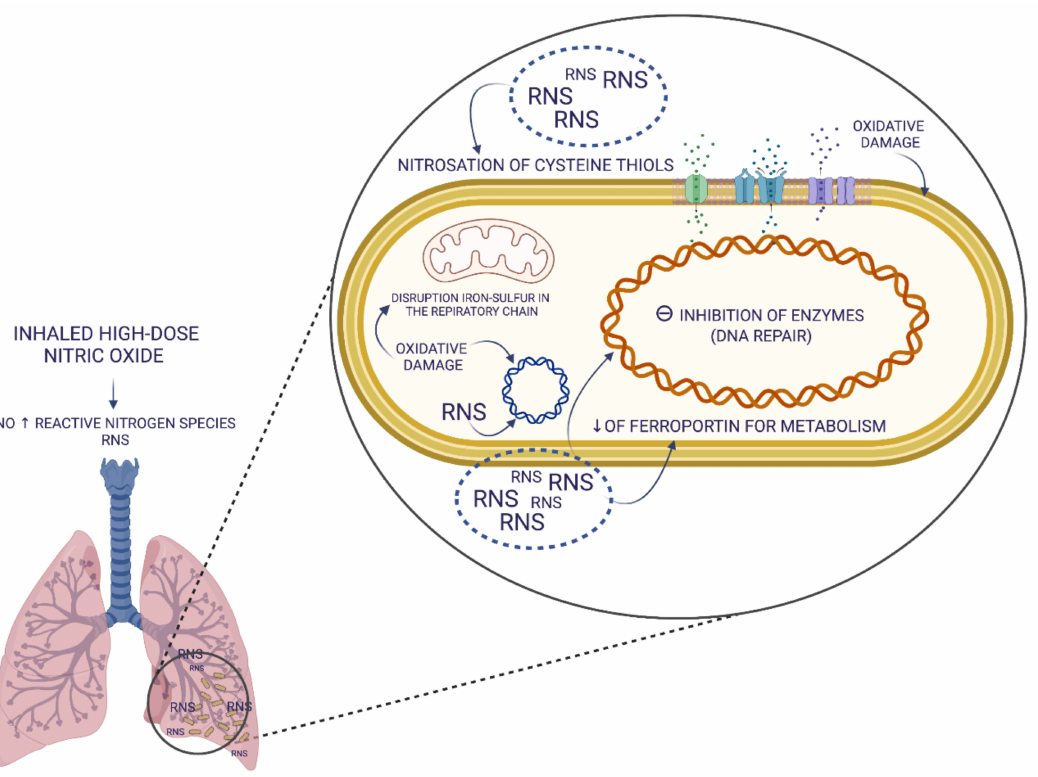
Figure 1. Schematic representation of multiple target structures of the antimicrobial actions of the reactive nitrogen species, which can kill or halt the growth of microorganisms. Definition of abbreviations: NO = nitric oxide, RNS = reactive nitrogen species. The figure was created with BioRender.com (accessed on 19 March